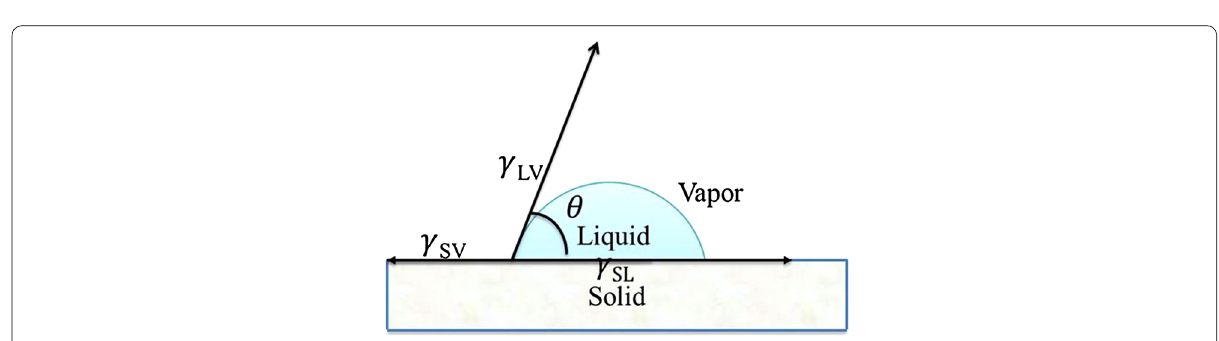
Fig. 5 SEM photographs of the a CPCMs‑4 with 1% EG ( 5% EG ( 5.0k) ×